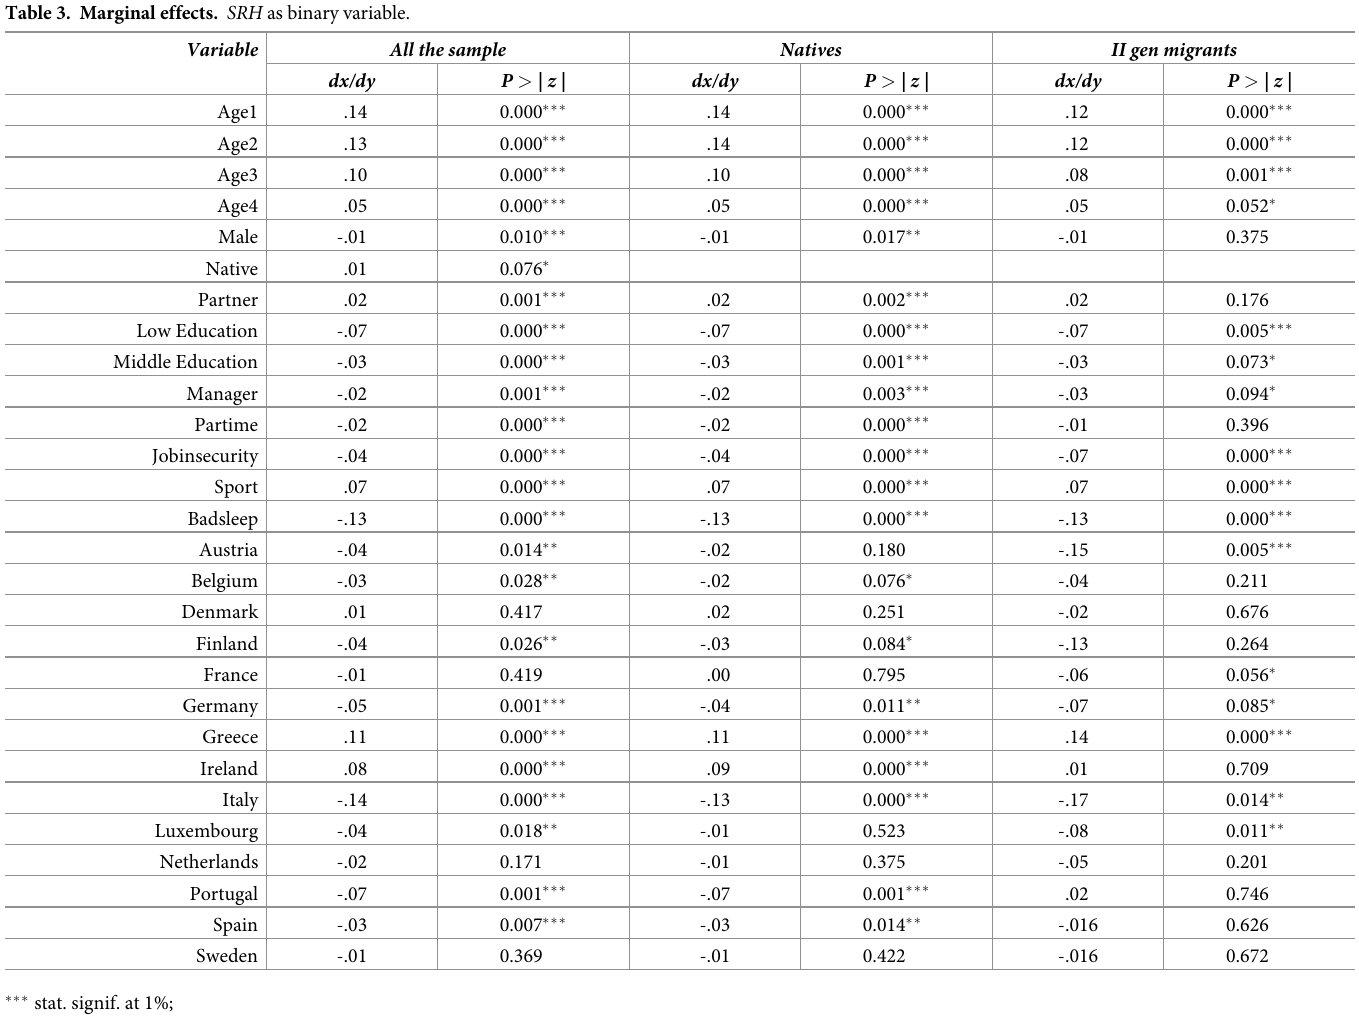
Table 3. Marginal effects. SRH as binary variable. Variable